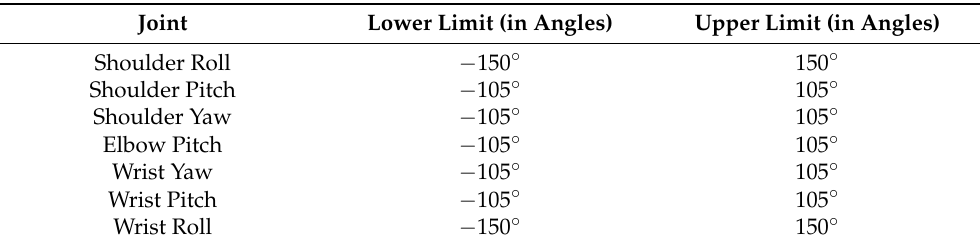
Table 1. 7-DOF RM Cyton